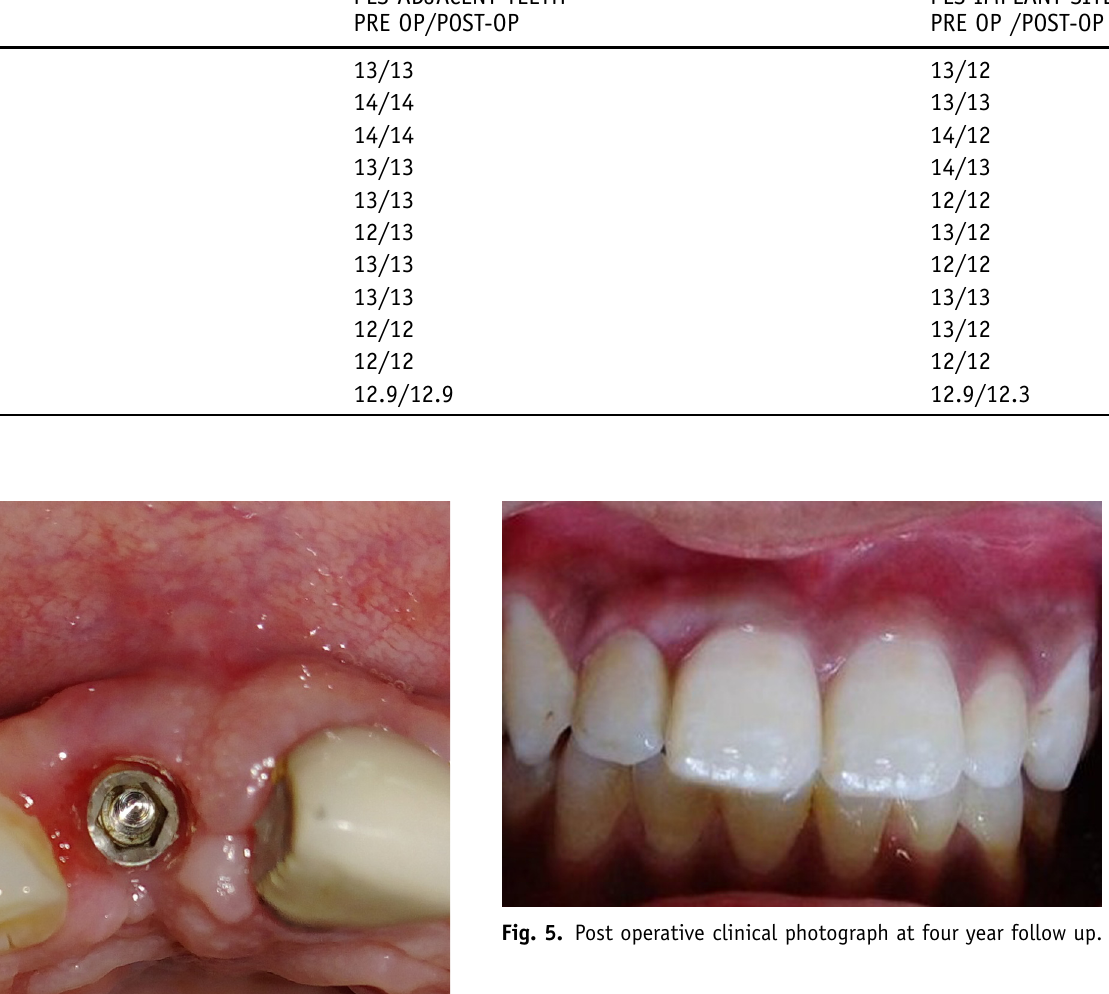
Table III. Showing changes in PES scores of adjacent teeth and implant site between pre-op and post-op visits. Sl no.